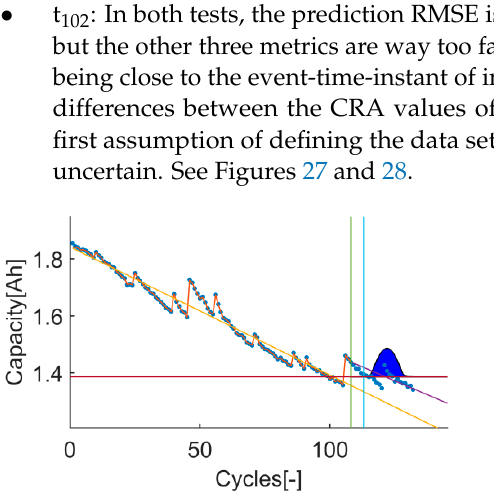
Figure 27. Time-instant figure of test 2 on t 102 .